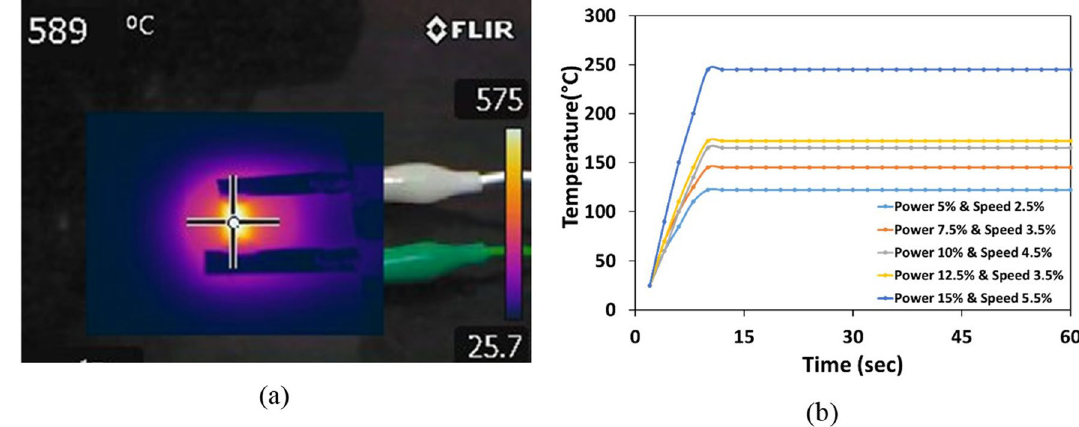
Figure 2. ( a ) Image from thermal camera showing a maximum temperature of 589 °C for an application of 15 V, ( b ) Time versus temperature plot for different combinations of heaters at a voltage of 9